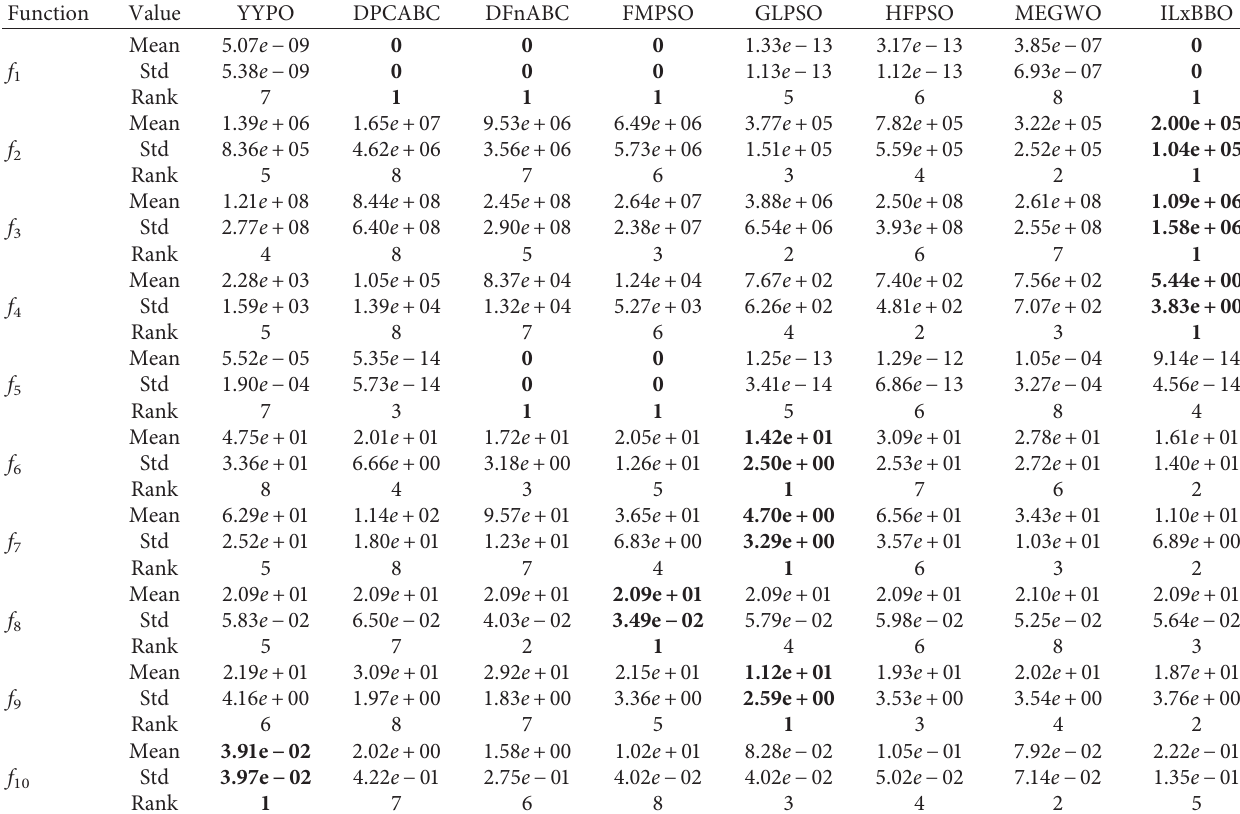
Table 4: Comparison results with the other IOAs on the 30-dimensional functions.